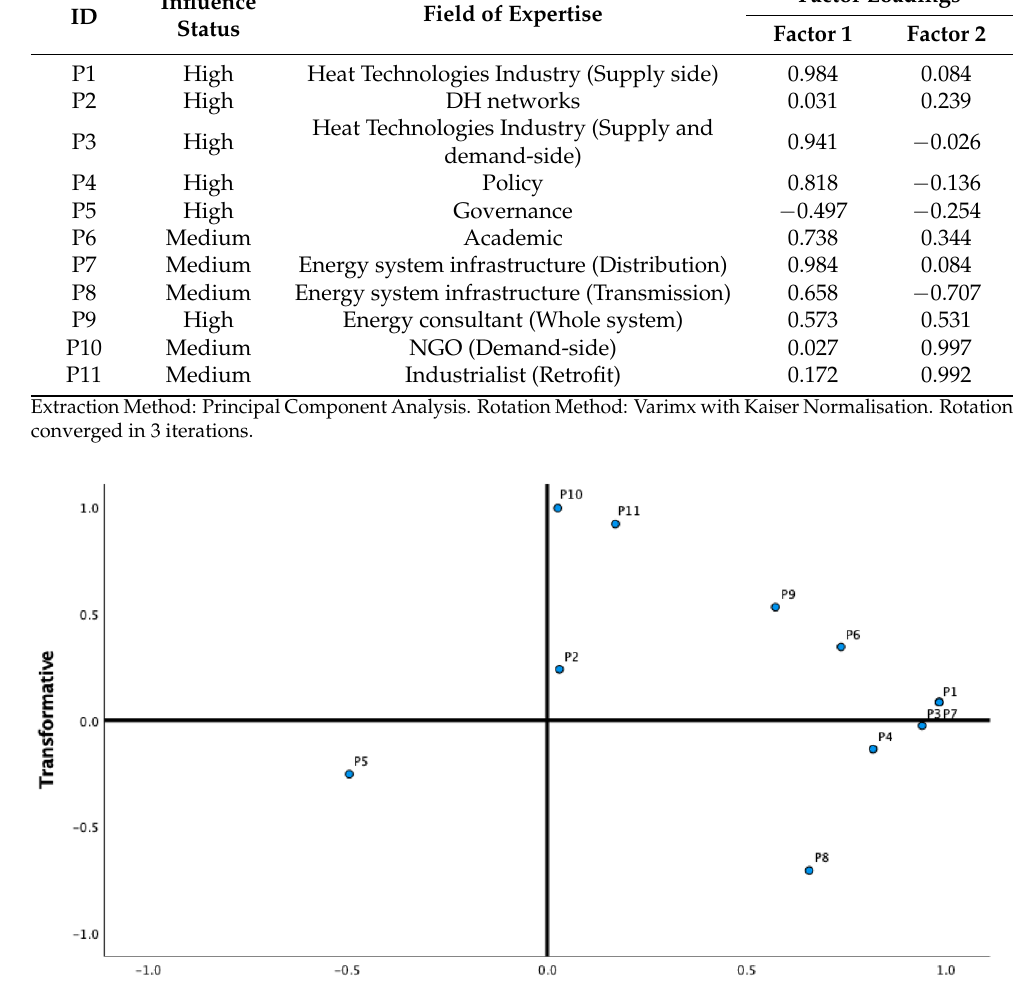
Table 1. Factor loadings of experts for top two components.